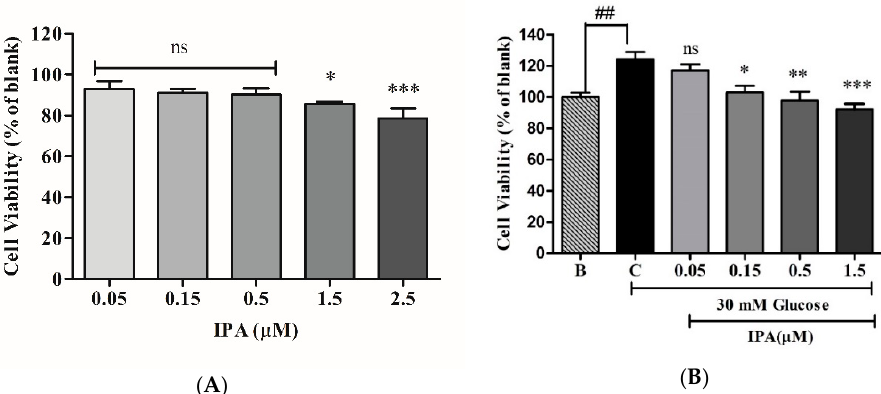
Figure 3. IPA inhibits the proliferation of EA.hy926 cells. ( A ) Cytotoxicity of IPA in EA.hy926 cells. The cells were treated with different IPA concentrations (0, 0.05, 0.15, 0.5, 1.5, and 2.5 µM) for 24 h, and the cell viability was determined by 3-(4,5-Dimethylthiazol-2-yl)-2,5-diphenyltetrazolium bromide (MTT) assay. The results were normalized to blank (0 µM IPA). ( B ) IPA inhibits the proliferation of high glucose-induced EA.hy926 cells. The cells were treated with different concentrations of IPA (0.05, 0.15, 0.5, and 1.5 µM), along with 30 mM glucose. MTT assay was performed to determine cell viability. The anti-proliferative effects of IPA in high glucose-induced cells were normalized to C (control (30 mM glucose + 0 µM IPA)), and the effects of 30 mM glucose were compared to B (blank (0 mM glucose + 0 µM IPA)). ns; not significant, * p ˂ 0.05, ** p ˂ 0.01, *** p ˂ 0.001, ## p ˂ 0.01.